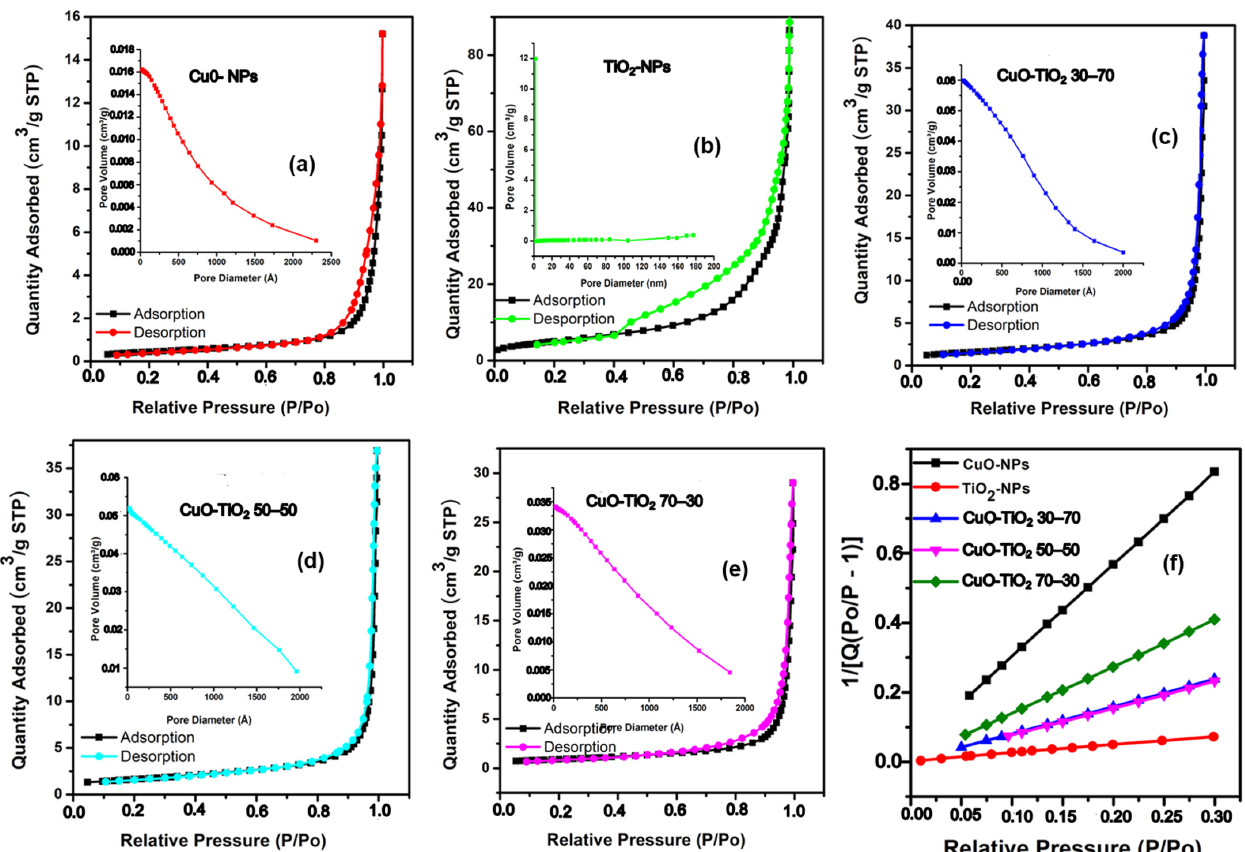
Figure 6. The adsorption ‐ desorption isotherms ( a – e ) with the pore volume distribution curve (inset) and ( f ) the surface area diagrams for TiO 2 , CuO, and CuO ‐ TiO 2 (30/70, 50/50, and